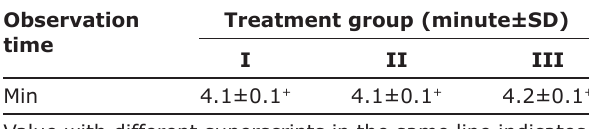
Table-7: Observation of objective drug